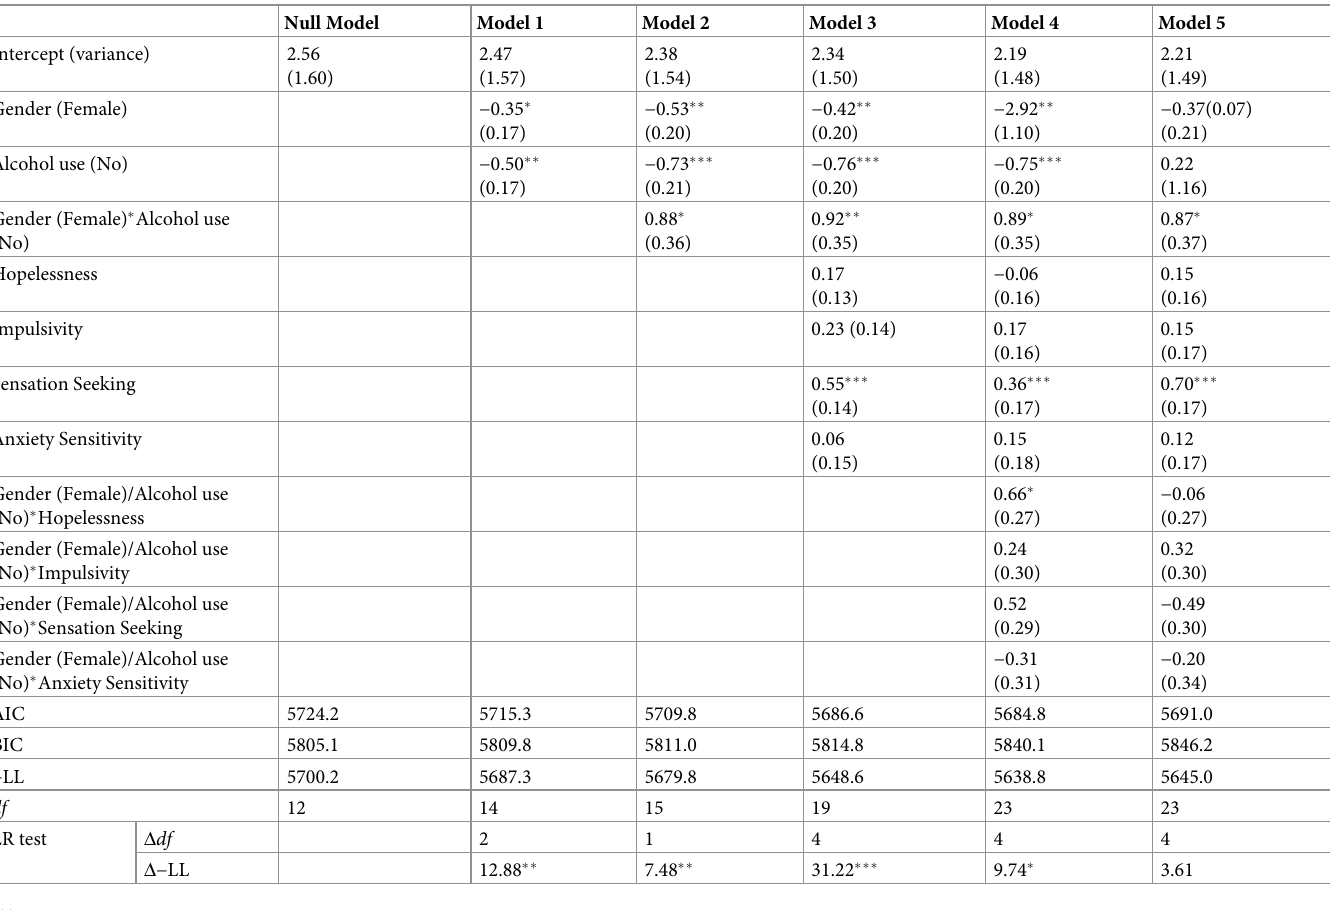
Table 4. Fixed effects and model comparison results from the explanatory IRT